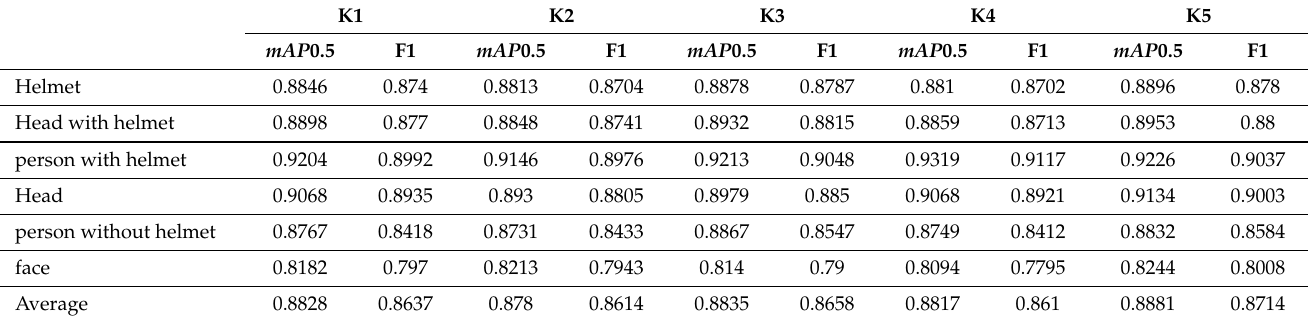
Table 7. The results of K-fold cross-validation on the SHEL5K dataset using the YOLOR model [16]. K1 K2 K3